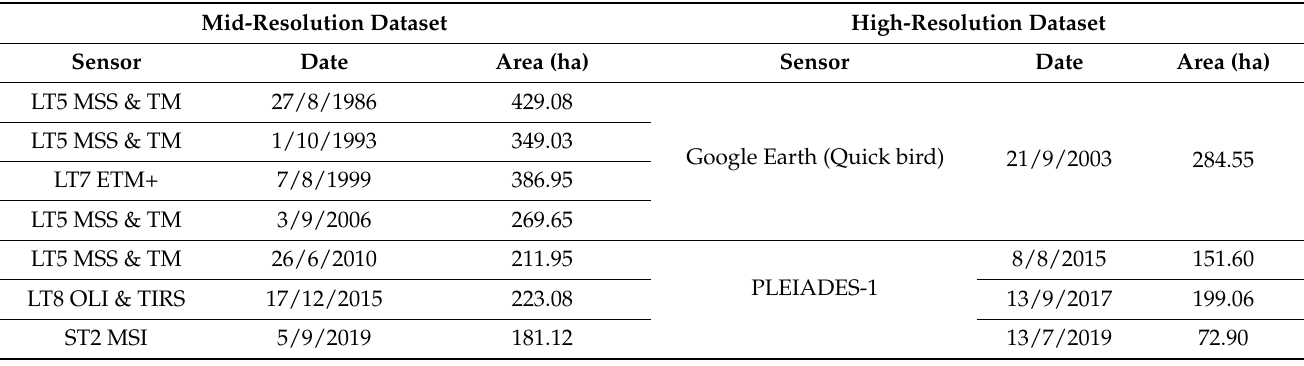
Table 3. Mangrove degraded areas from 1986 to 2019 using mid and high-resolution datasets.